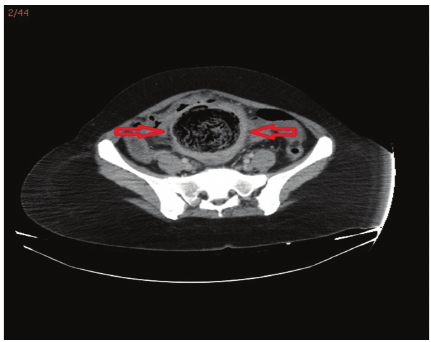
Figure 1: Abdominal CT scan revealed intra-abdominal mass— gossypiboma.